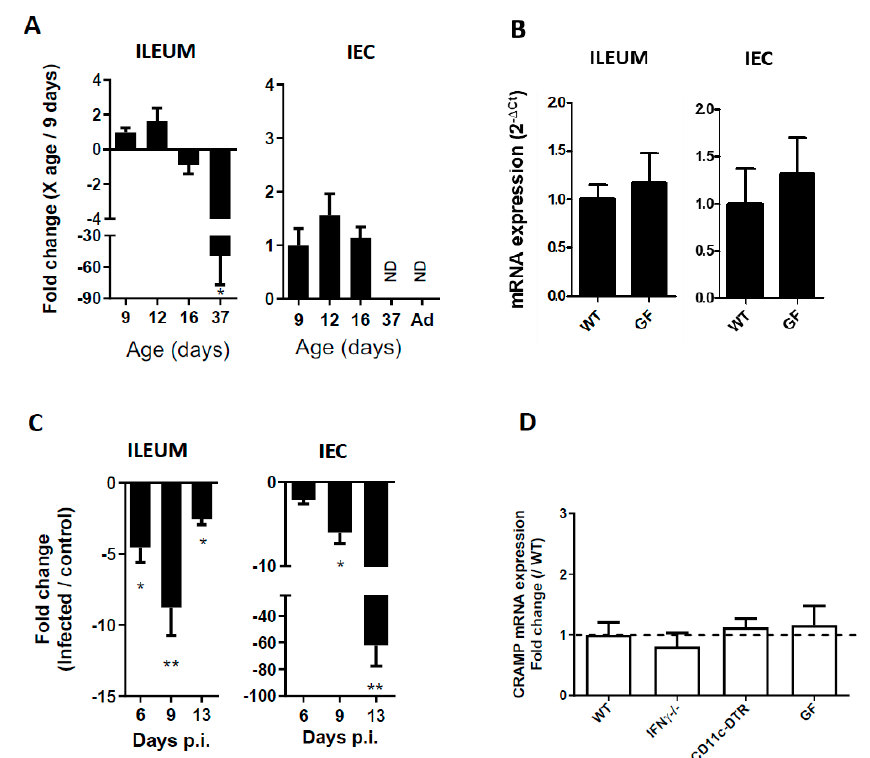
Figure 1. Ileal Cathelicidin Related Antimicrobial Peptide (CRAMP)expression is reduced during Cryptosporidium parvum infection of neonatal mice. mRNA expression is measured by qRT-PCR in different conditions. ( A ) CRAMP mRNA levels were determined in the whole mucosa of ileum (left panel) and in purified intestinal epithelial cells (IEC) (right panel) of non-infected mice at different ages. n ≥ 5 mice per group. ( B ) The absence of microbiota does not modify CRAMP expression. CRAMP mRNA levels were determined by qRT-PCR in the whole mucosa of ileum (left panel) and in purified intestinal epithelial cells (IEC) (right panel) of germ-free (GF) and Wild-Type (WT) neonatal mice at 16 days of age. ( C ) CRAMP mRNA expression is significantly decreased during C. parvum infection of neonatal mice. Three-day-old neonatal mice were orally infected with 5.10 5 oocysts of C. parvum and euthanized at day 6, 9 and 13 pi for analysis of CRAMP expression in the ileum by qRT-PCR. Each group of mice is composed of 6 to 11 neonatal mice. ( D ) The reduced mRNA expression of CRAMP in the neonatal intestine is independent of the microbiota (GF mice) and IFN γ , and of CD11c+ cell recruitment. Three-day-old neonatal mice were orally infected with 5.10 5 oocysts of C. parvum and euthanized at day 9 pi (for CD11cDTR and IFN γ -/- mice) and 13 pi for GF mice. These data are from one experiment representative of two. Mann–Whitney non-parametric test * p < 0.05, ** p < 0.01. ND: not